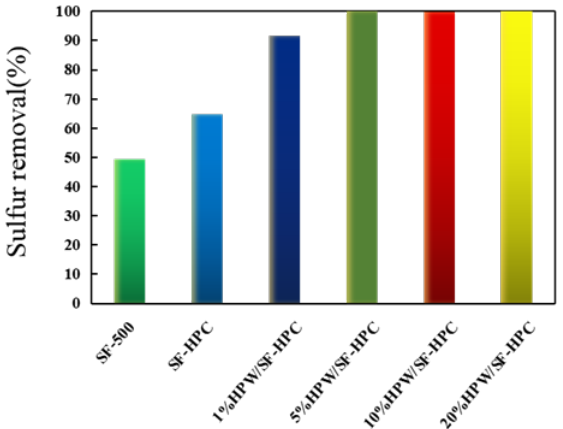
Figure 6. The sulfur removal rate in the ODS process with different HPW contents.